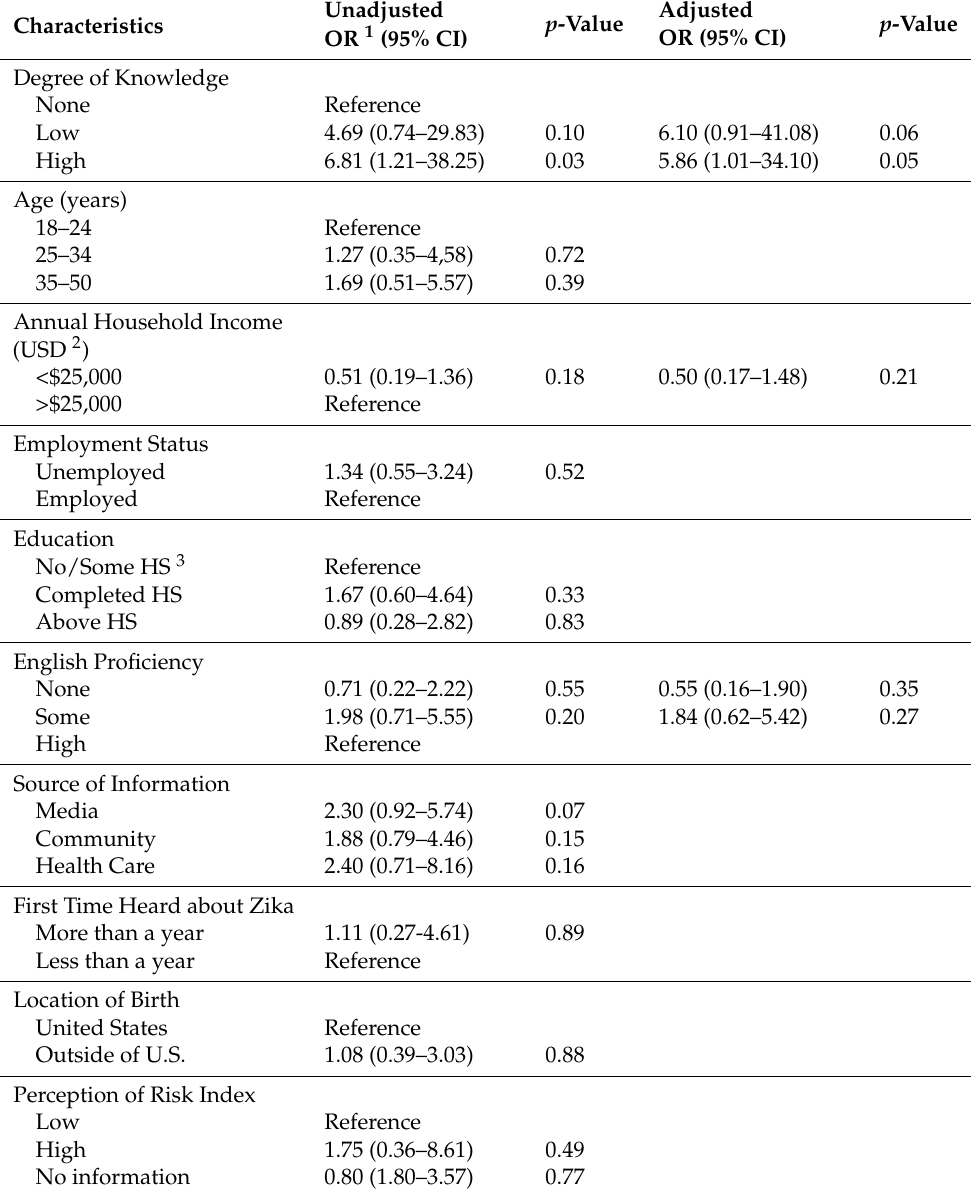
Table 3. Unadjusted and adjusted association between Zika knowledge and level of use of preventative measures among Latinas of childbearing age in South Florida ( n =